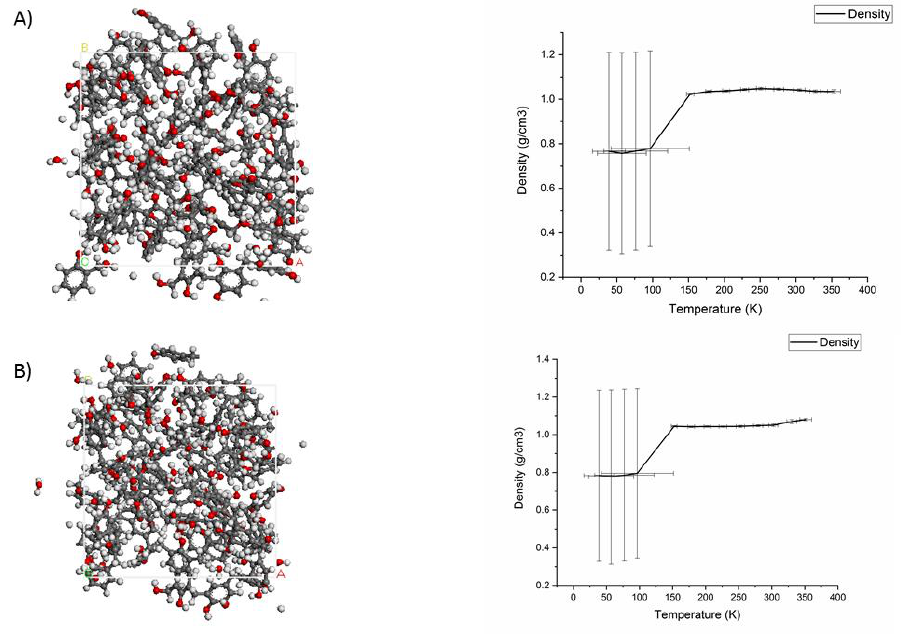
Figure 2. (A) Model of 1000 atoms, 33% cured and temperature cycle data for 1000 atoms, 33% cured. ( B ) Model of 1000 atoms, 66% cured and temperature cycle data for 1000 atoms, 66% cured.